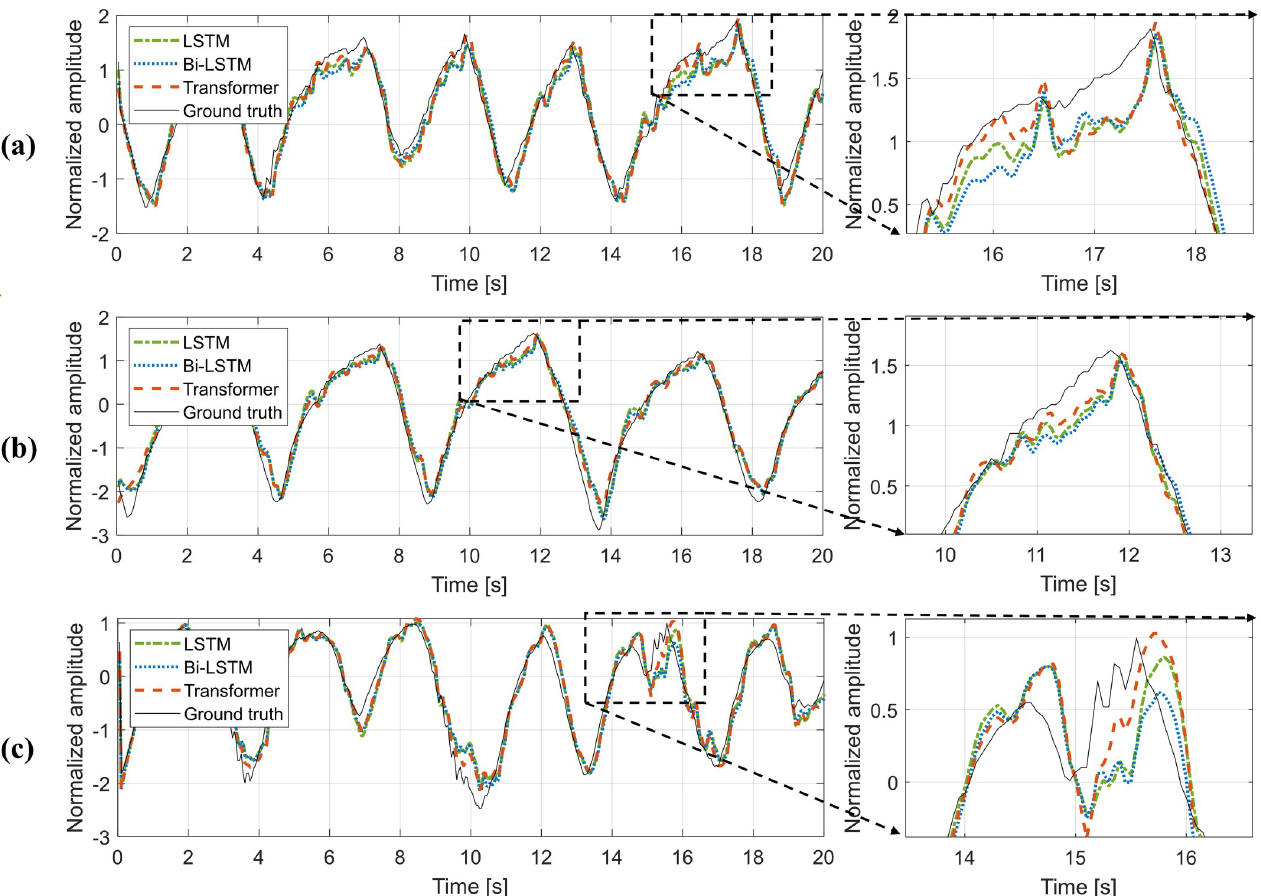
Fig 5. Actual and predicted respiratory signals for three different patterns of irregular respiration. (a) irregular pattern with periods, (b) irregular pattern with amplitude, and (c) irregular pattern with periods and